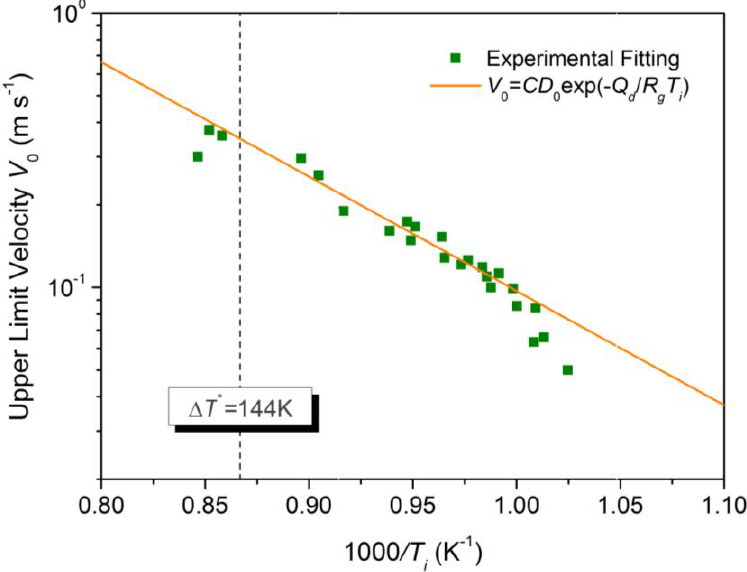
Figure 15. Arrhenius plot of the upper limit of growth velocity V 1000 times the reciprocal interface temperature 1000/ T results of the computations (solid